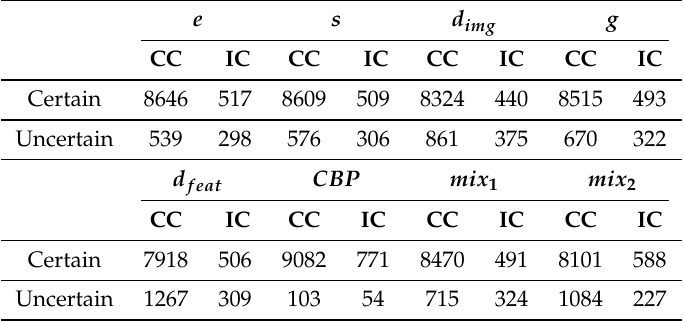
Table 7. Confusion matrices on MNIST, where CC and IC are the correctly and incorrectly classified samples, respectively.